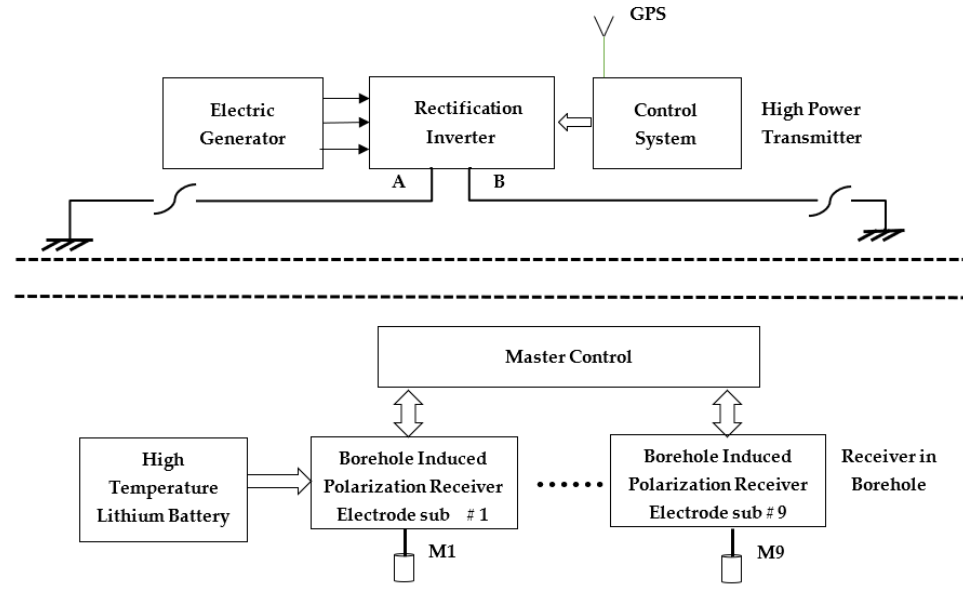
Figure 3. Hardware